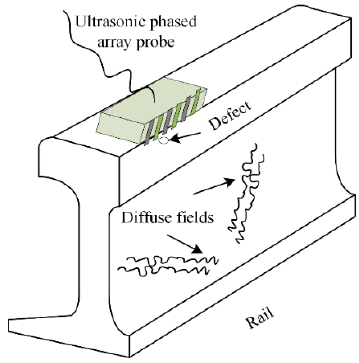
Figure 2. The experimental facility and diffuse fields in rail.